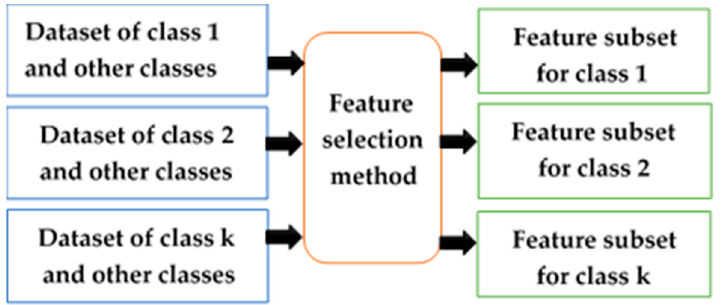
Figure 3. Class-dependent feature selection technique.